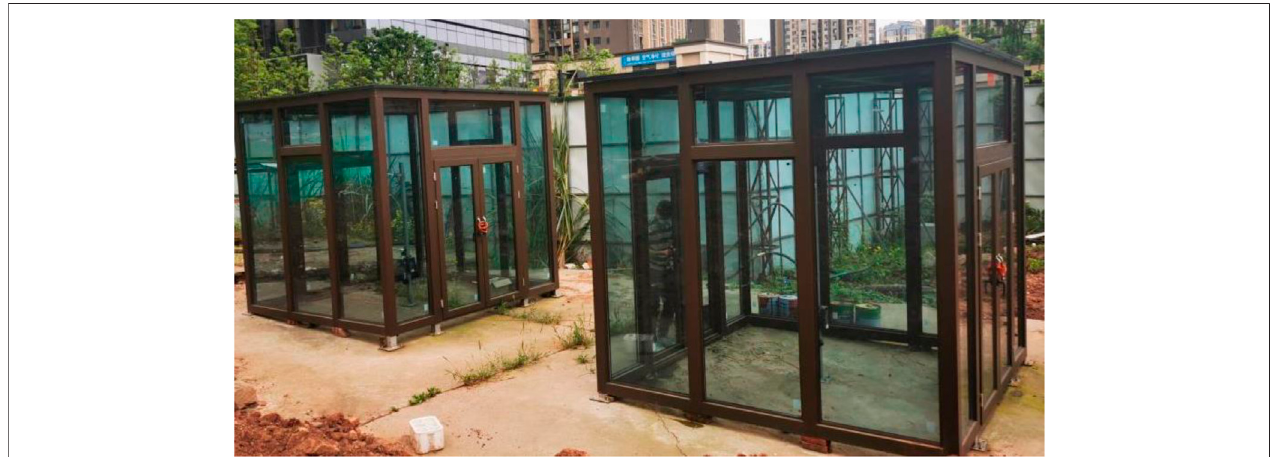
FIGURE 6 | Comparison of thermochromic glass and ordinary Low-E glass sunlight room.